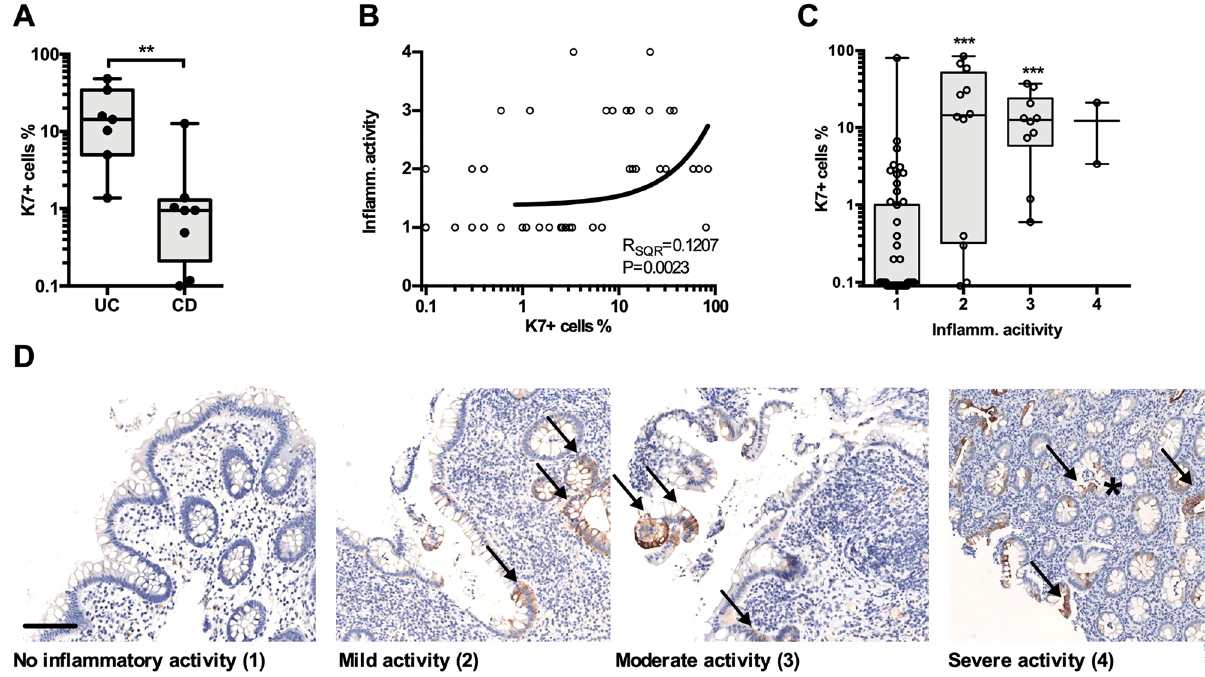
Figure 6. K7 is focally expressed in healthy epithelium of IBD patents, but the K7 positive cell percentage is yet lower than in inflamed areas. Samples were derived from UC (N = 7), and CD (N = 8) patients in cohort B, including total 75 biopsies. ( A ) The mean percentage of K7 positive cells was higher in UC than CD patients with drug responsive IBD. Each dot represents an average K7 + cell percentage among the biopsies collected from a single patient. ( B ) Increased local inflammatory activity correlated with the percentage of K7 + cell in colon biopsies. ( C ) The percentage of K7 + cells according to the inflammatory activity where biopsies were graded on a scale from 1 to 4 (1: no activity, 2: mild. 3: moderate, 4: severe) is shown. Circles represented individual biopsy sample in ( B ) and ( C ). ( D ) Representative K7 IHC staining (brown) in each inflammatory activity category is shown by arrows, and crypt abscess by asterisk. Correlation of two variables was assessed using linear regression analysis. Mann–Whitney test was used in pair way comparison. The significance between more than two groups was measured using Dunn’s multiple comparison test. **P < 0.01; ***P < 0.001.